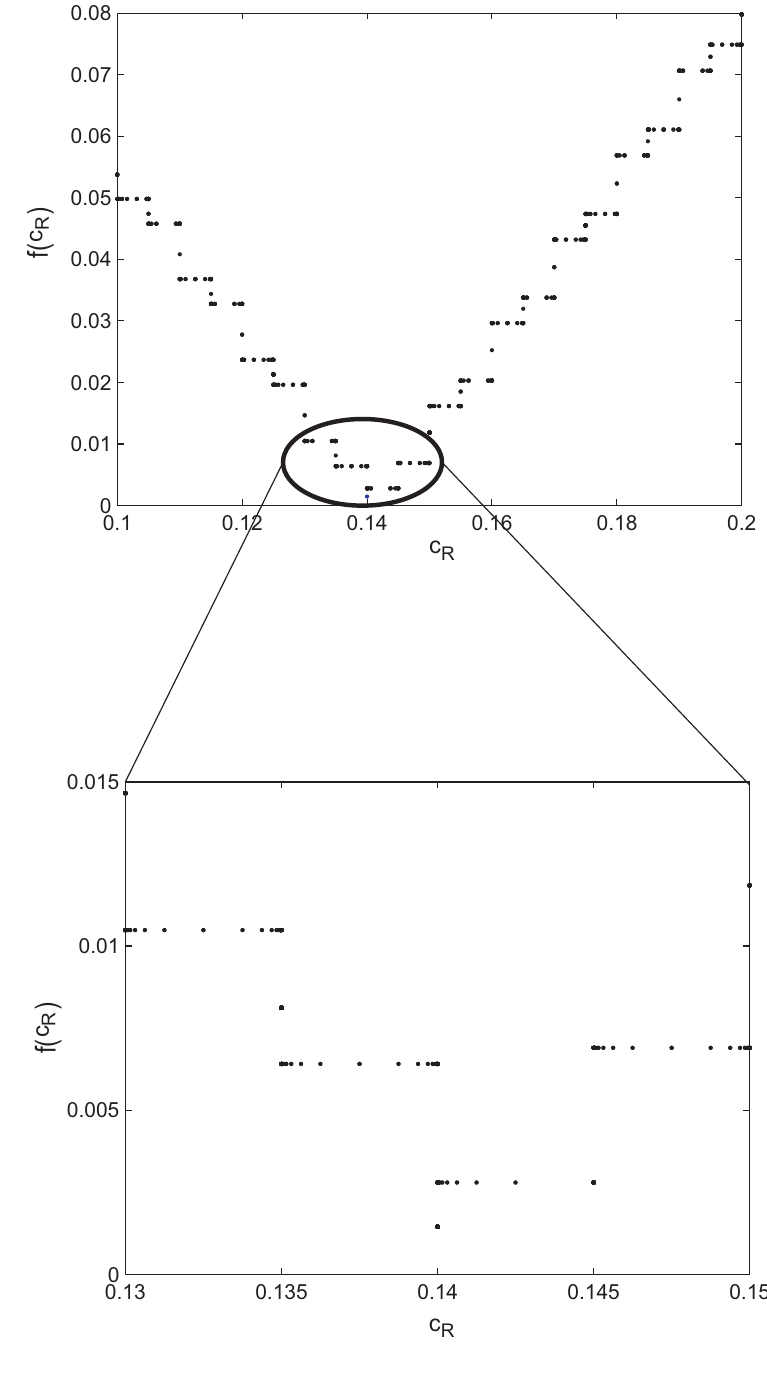
Figure 2. The objective function and zoom of the stop-loss reinsurance optimization